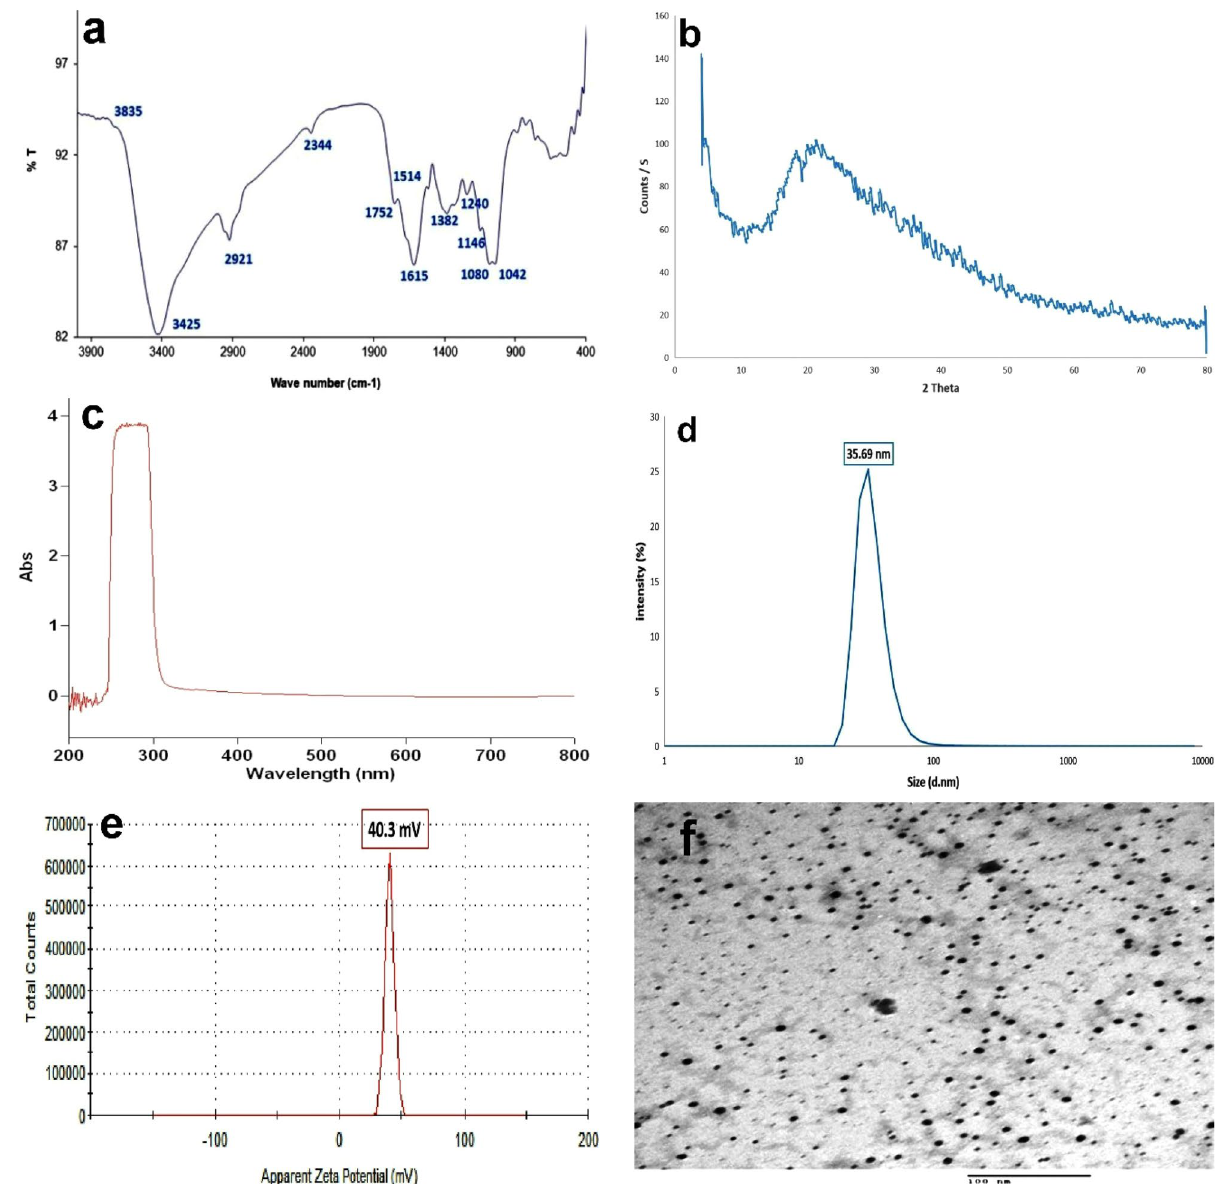
Figure 1. Characterization of the prepared CS-NPs. ( a ) Elemental structure by FTIR. ( b ) Physicochemical structure by XRD. ( c ) Peak absorption. ( d ) The particle size distribution curve. ( e ) Average zeta potential. ( f ) Transmission electron microscope